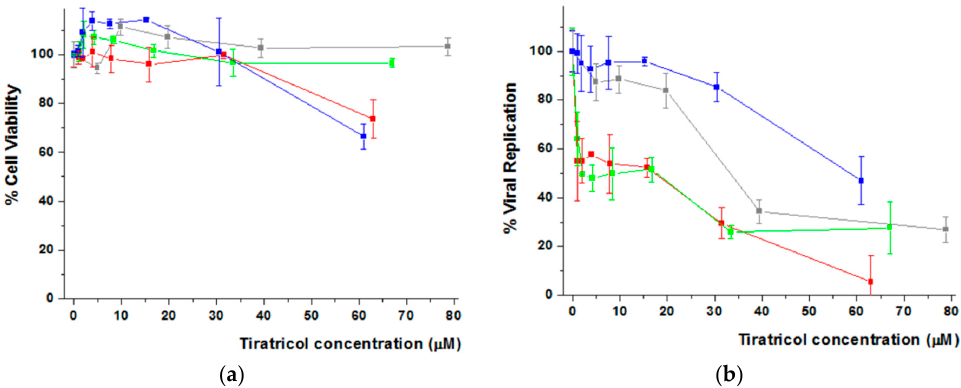
Figure 7. Cell Viability ( a ) and HCV viral replication ( b ) of Free and loaded TRIAC in Janus dendrimers in Huh 5-2 cell line. All the data are presented as the average ± standard deviation. Free TRIAC (Grey Line) (NH 3 + ) 8 [GMPA]-[MPA](C17) 2 / TRIAC (Red Line) (NH 3 + ) 8 [GMPA]-[MPA](C17) 4 / TRIAC (Green Line) (NH 3 + ) 8 [MPA]-[GMPA](C17) 2 / TRIAC (Blue Line).